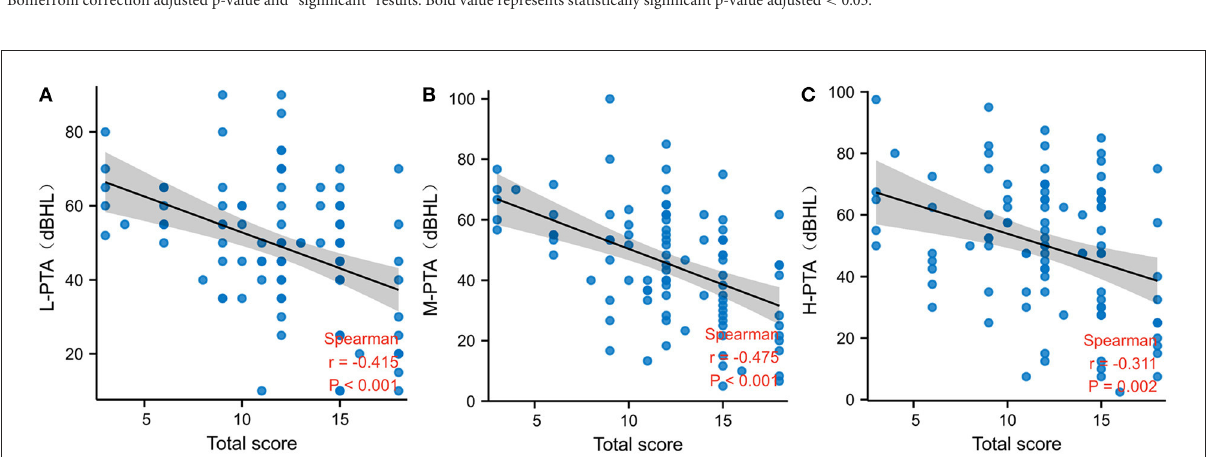
FIGURE3 Correlation between IESAM total scores and pure tone hearing thresholds in the Ménière’s patients. (A) Negative correlation between low-frequency hearing thresholds and total scores; (B) Negative correlation between mid-frequency hearing thresholds and total scores; (C)